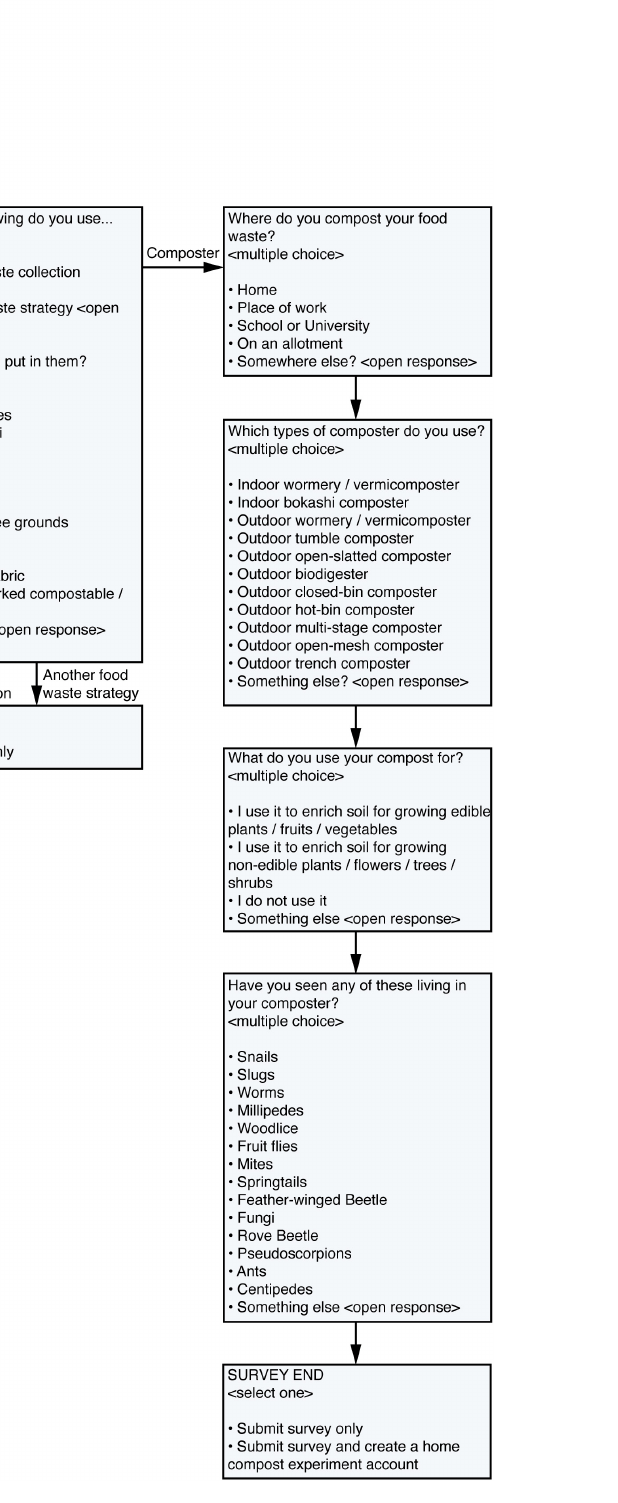
FIGURE1 Illustration of the Big Compost Experiment online survey